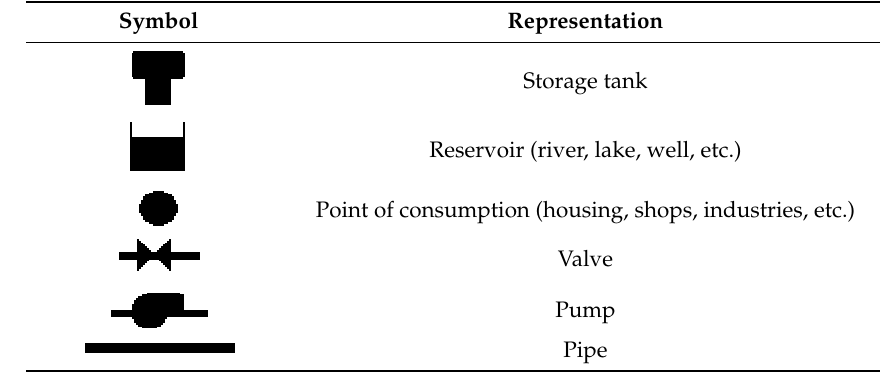
Table 2. Summary of the FRM Table 2. Summary of the FRM network. Table 2. Summary of the FRM network. Table 2. Summary of the FRM network. Table 2. Summary of the FRM network. Table 2. Summary of the FRM network. Table 2. Summary of the FRM network.